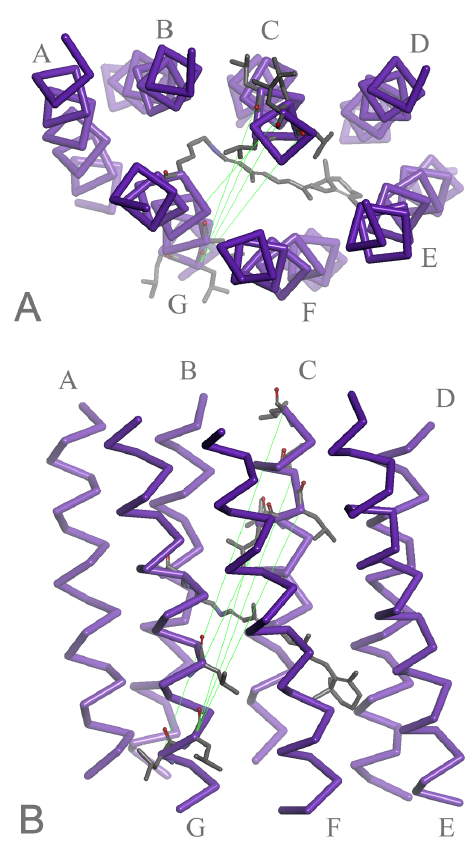
Figure 6. Graphical representation of conserved interhelical distances in set 3 including 13 unique bundles from all MRs with known structure. A . Top view from the cytoplasmic side. B . Side view from helices F and G. The pairs between helices C and G with high scores are connected by green lines drawn on chain A of 1PY6 (bR). A retinal chromophore attached to Lys(7.50) is also shown in the